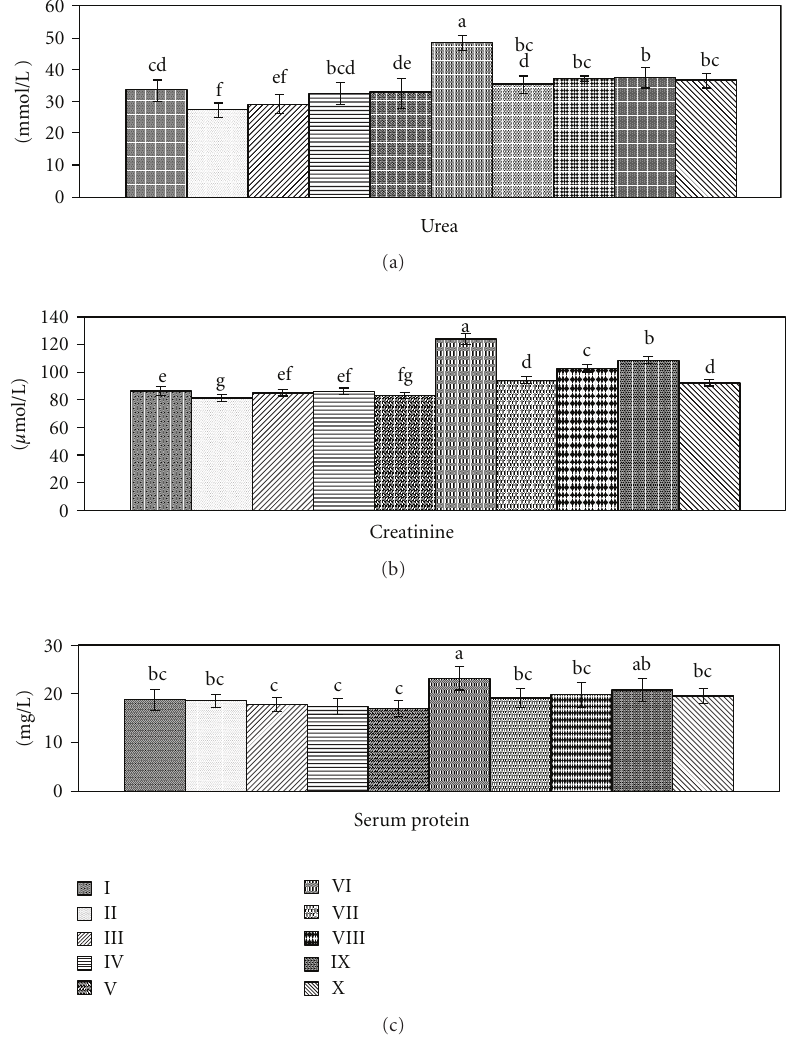
Figure 2: E ff ect of Zingiber o ffi cinale on kidney function parameters: urea, creatinine, and serum protein. Groups I: control, II: control treated with ethanol extract, III: control treated with chloroform extract, IV: control treated with petroleum ether extract, V: control treated with silymarin, V1: intoxicated with CCl 4 , VII: intoxicated with CCl 4 and treated with ethanol extract, VIII: intoxicated with CCl 4 and treated with chloroform extract, IX: intoxicated with CCl 4 and treated with petroleum ether extract, and X: intoxicated with CCl 4 and treated with silymarin. Data are mean ± SD of six rats in each group. Statistical analysis was carried out by one-way analysis of variance (ANOVA); Costat Computer Program. Unshared letters are significance values between groups at P < 0 .